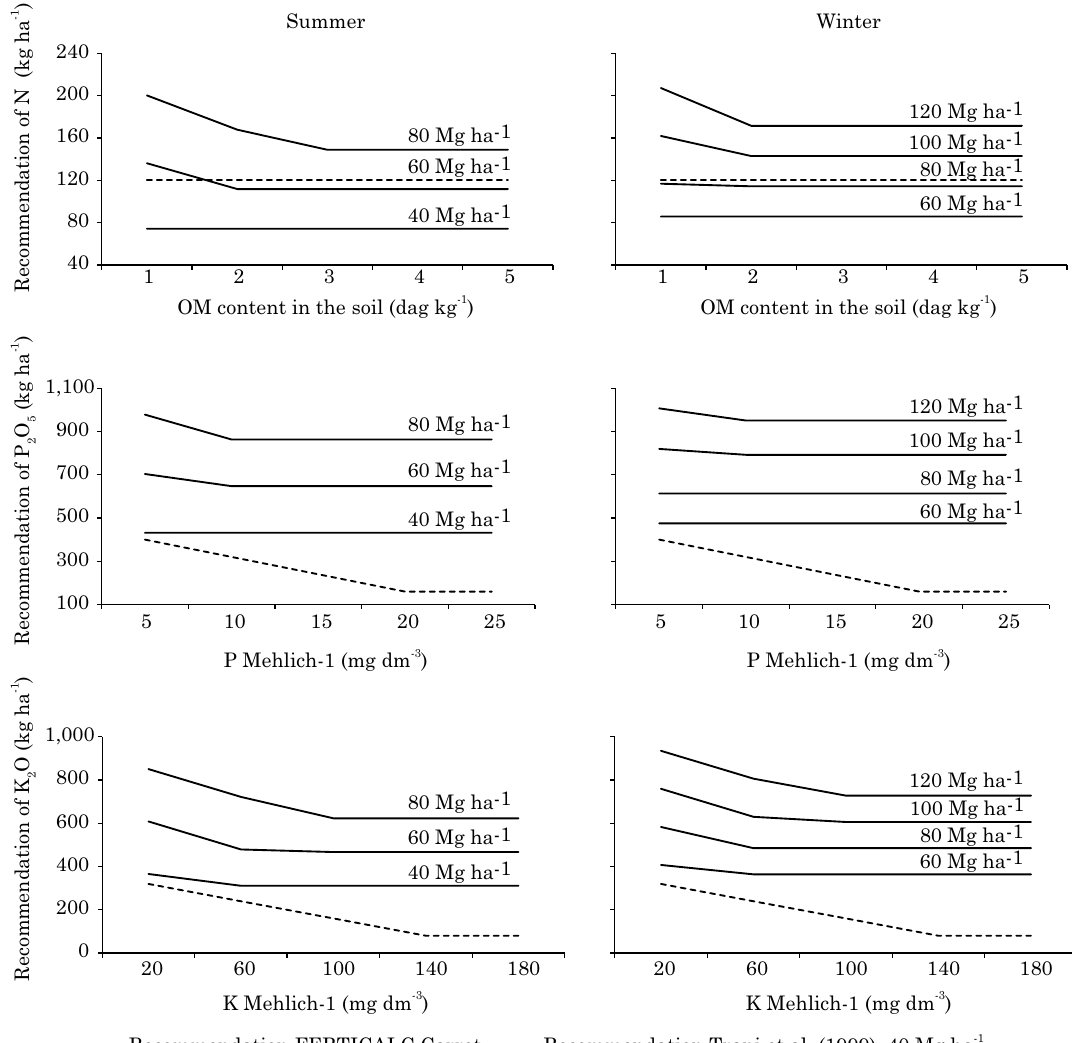
figure 1. analysis of sensitivity of ferticalc carrot for recommendation of N, p 2 o 5 , and K 2 o as a function of properties of soil chemical analysis, yield expectation, and crop season (winter or